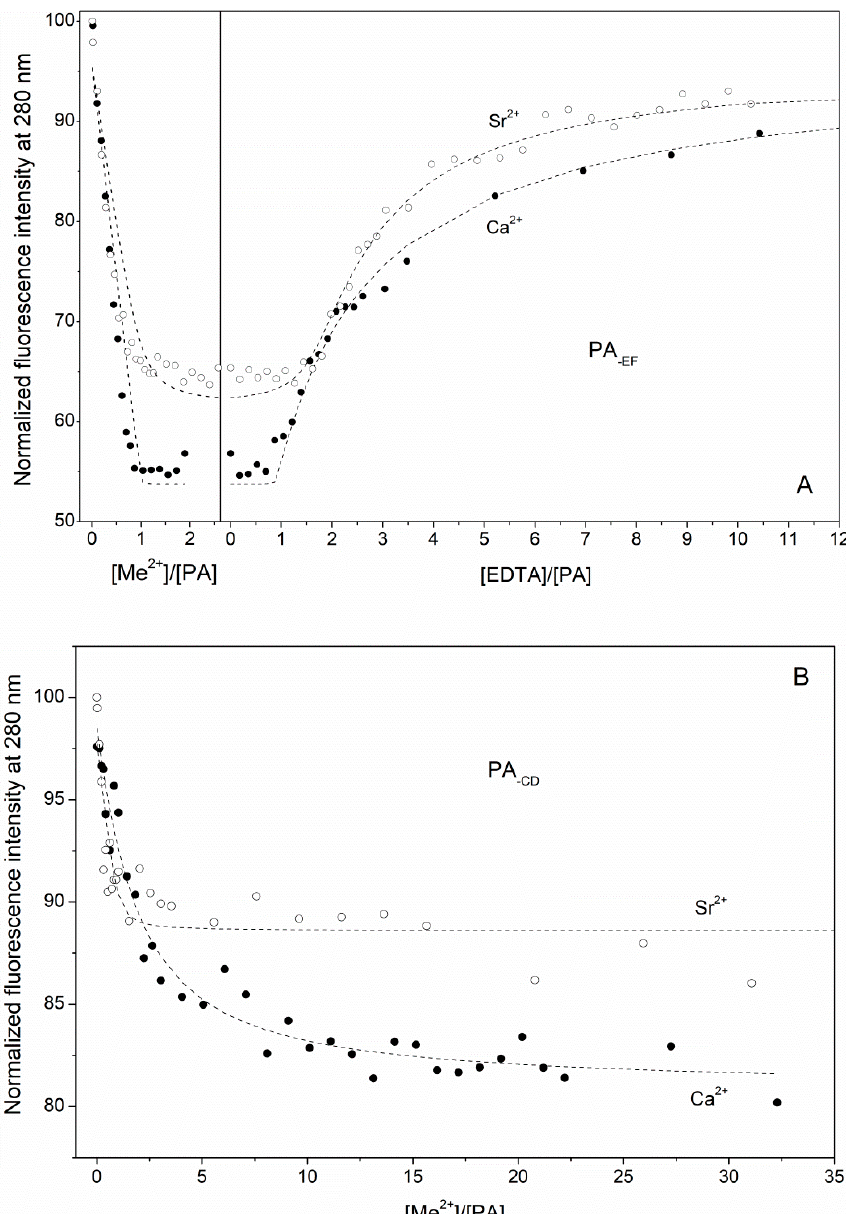
Figure 3. The interaction of Sr 2+ /Ca 2+ with PA -EF ( A ) and PA -CD ( B ) at 20 °C, followed by Phe fluorescence (10 mM HEPES-KOH pH 8.1). Protein concentration is 14–19 µM. Fluorescence was excited at 259 nm. The points are experimental. The curves are approximated by the single site metal binding scheme (3). In the case of PA -EF , the competition between the protein and EDTA for metal ions (scheme (2)) is taken into account.